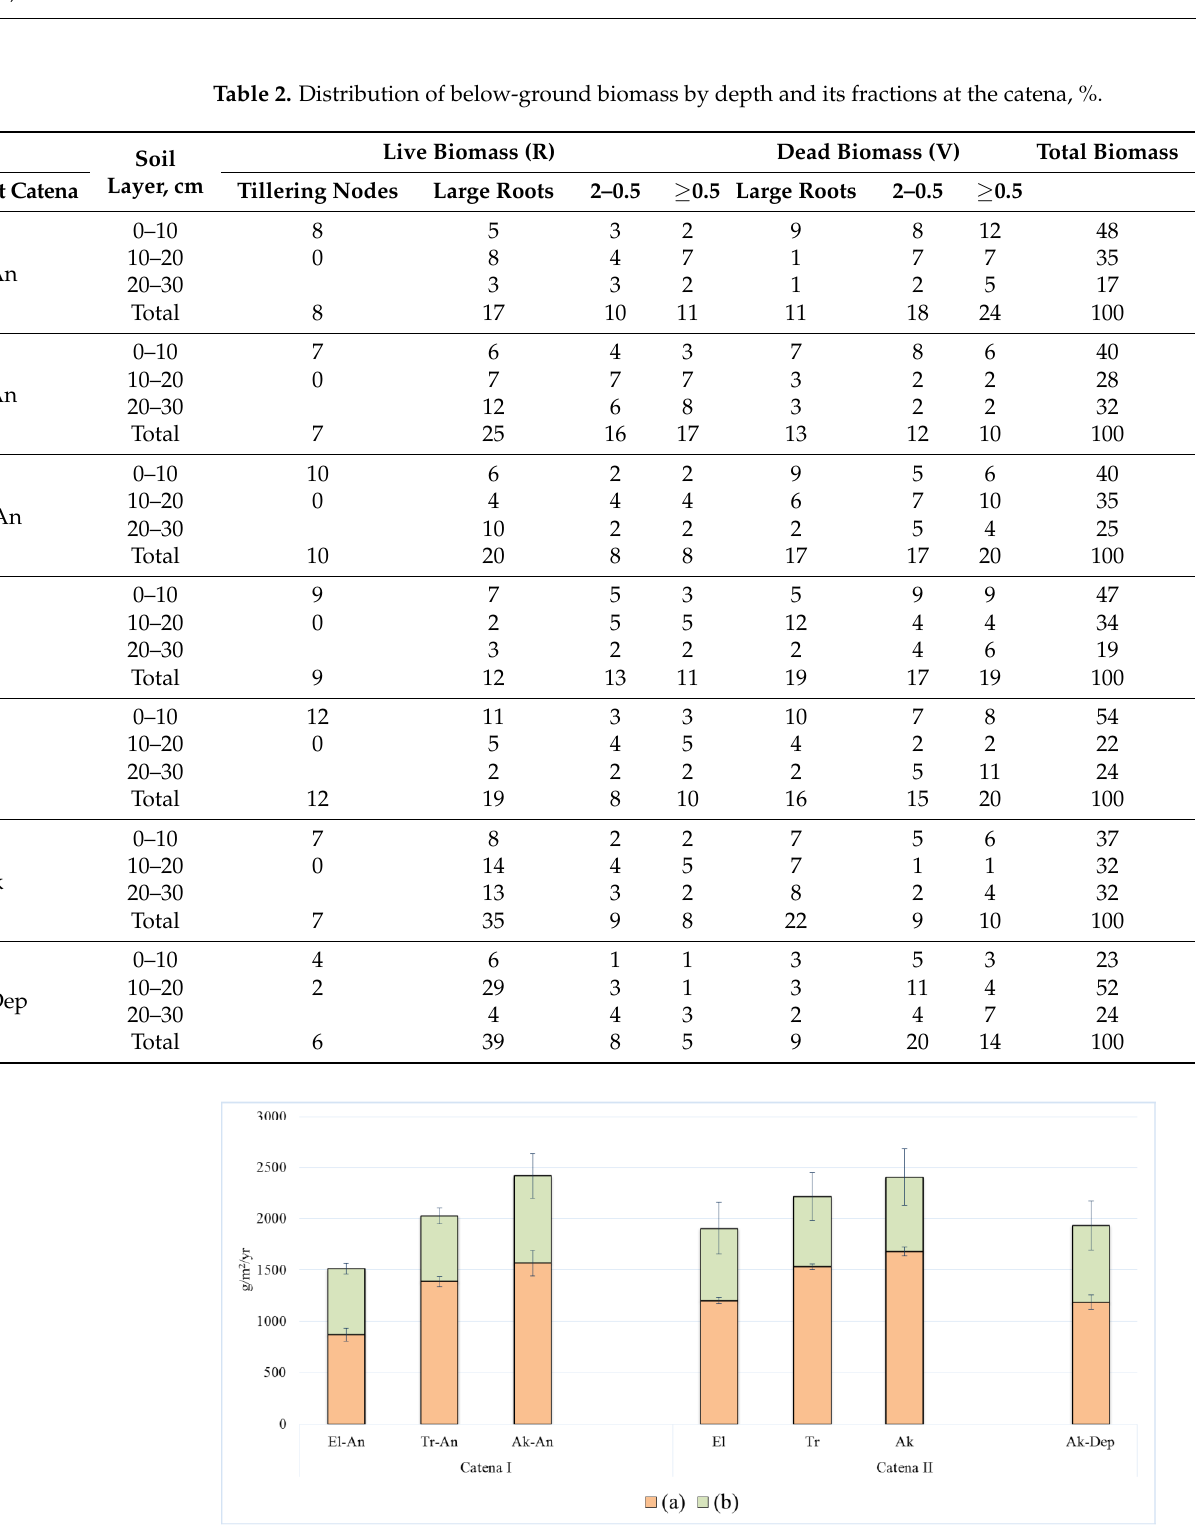
Figure 5. Net primary production (NPP): (a) BNP, below-ground fraction of NPP; (b) ANP, above-ground fraction of NPP, g/m 2 /year. ground fraction of NPP, g/m 2